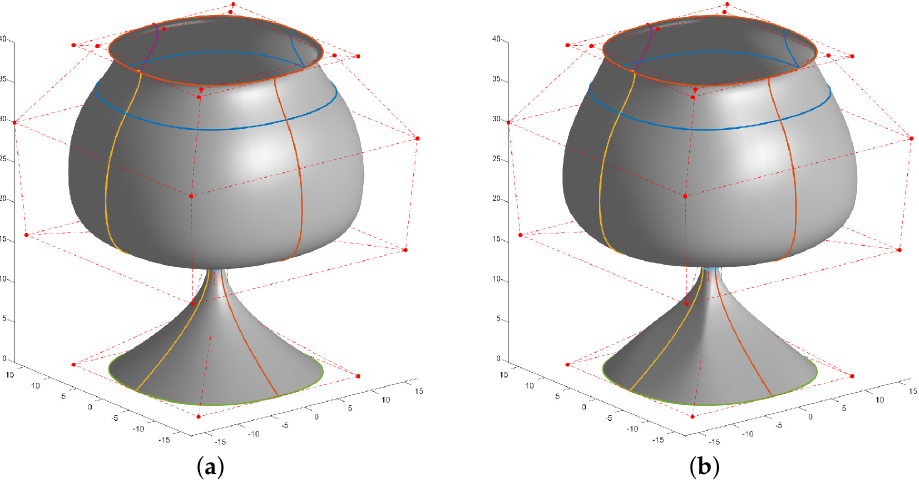
Figure 9. ( a ) Tensor product and ( b ) triangulated surfaces with R = m = 3, S = 3, n = 4, 0,0,0,1,2,3,4,4,4 , V = 0,0,0,1,2,3,4,5,5,5 U = { } {